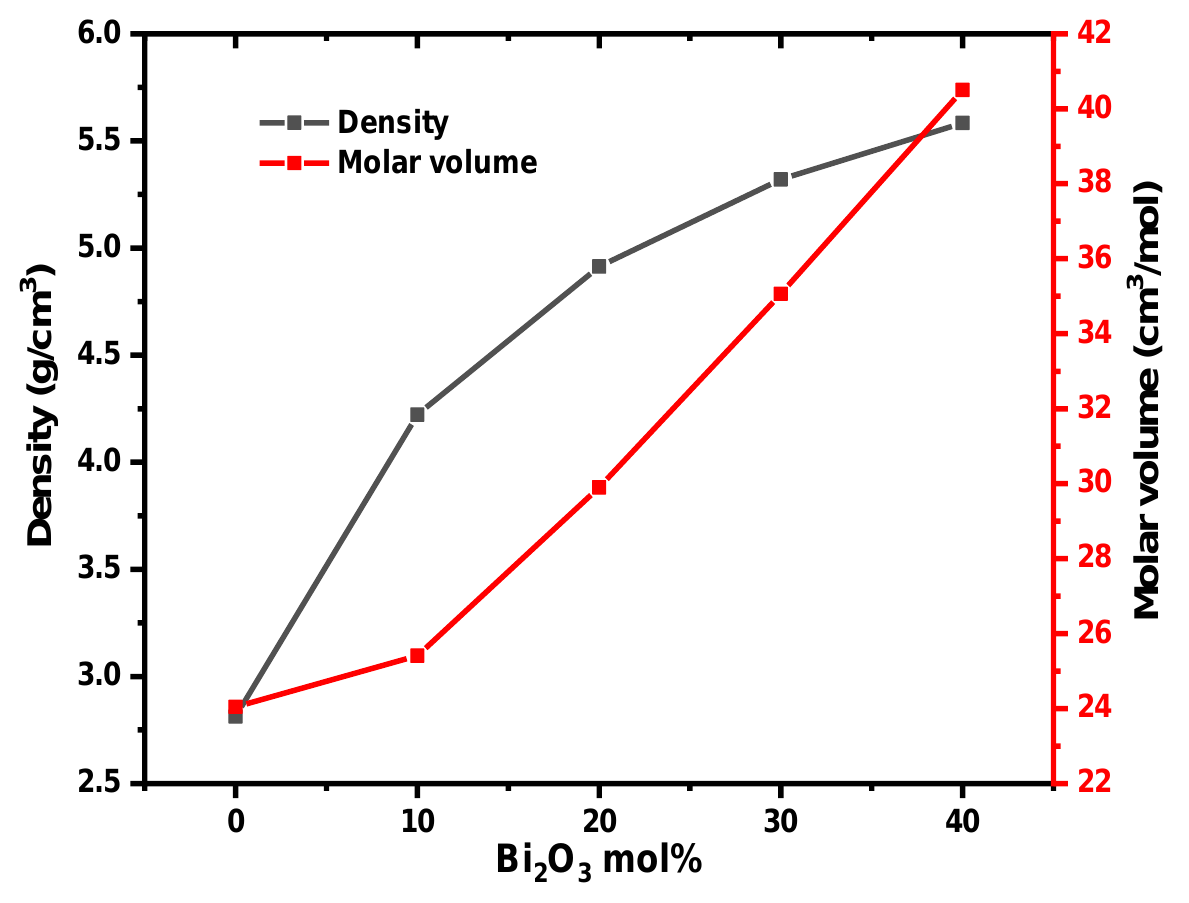
Figure 5. Density and molar volume for present glass samples.